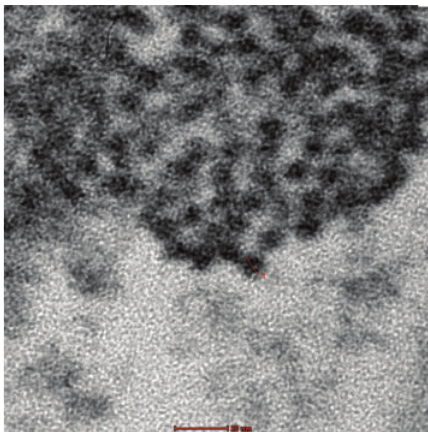
Figure3:TEMimagesofAgNps(redarrows)incytoplasmaticspace of fibroblast present in a healed skin sample treated with AgNP based medical devices. The diameter of particles released from the medical devices are of 20nm, indicating that their aggregates are able to enter the cells by endocytosis.